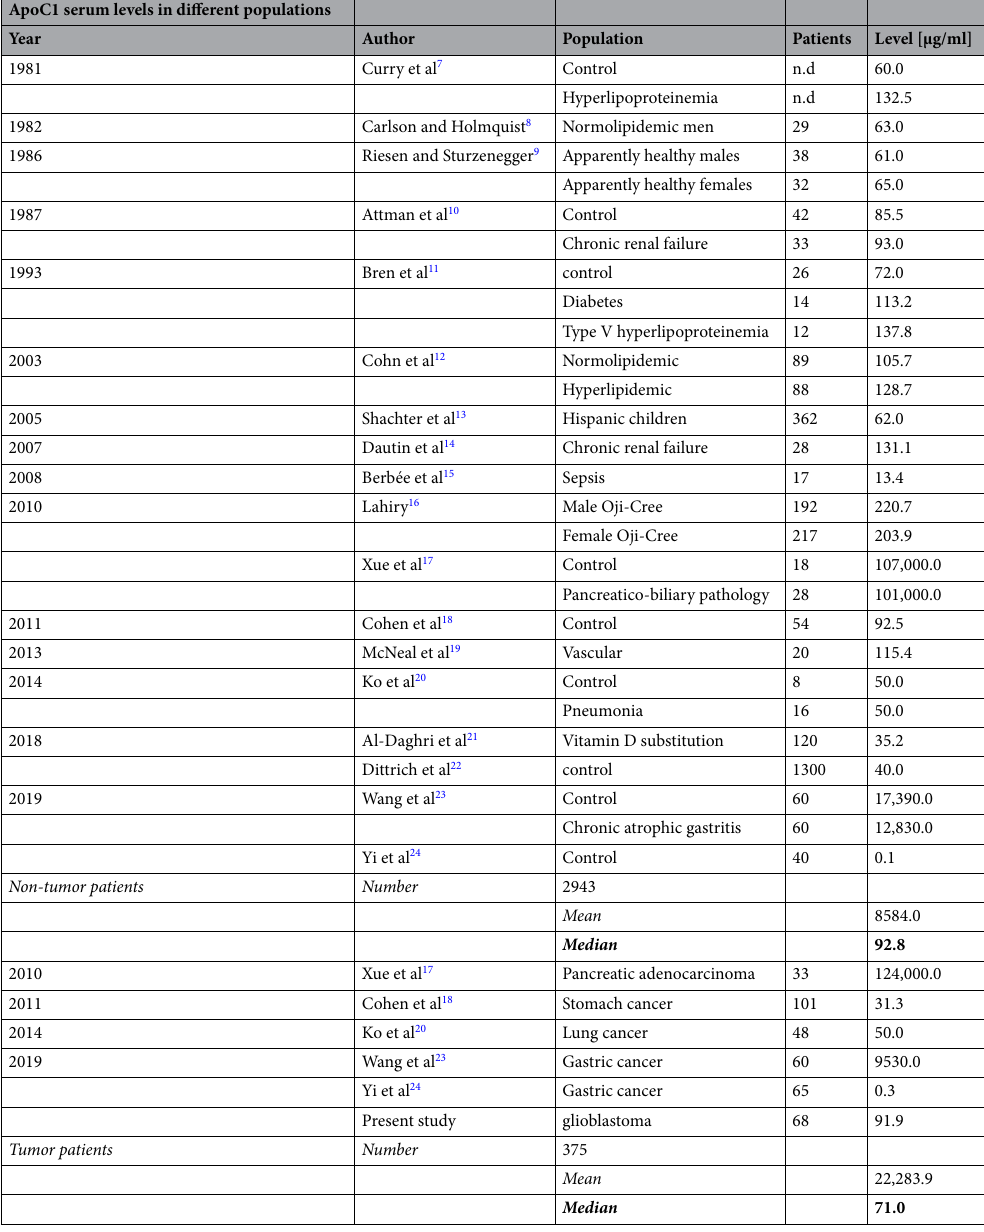
Table 3. Overview of published ApoC1 serum levels. n.d.: not disclosed. Median values are in